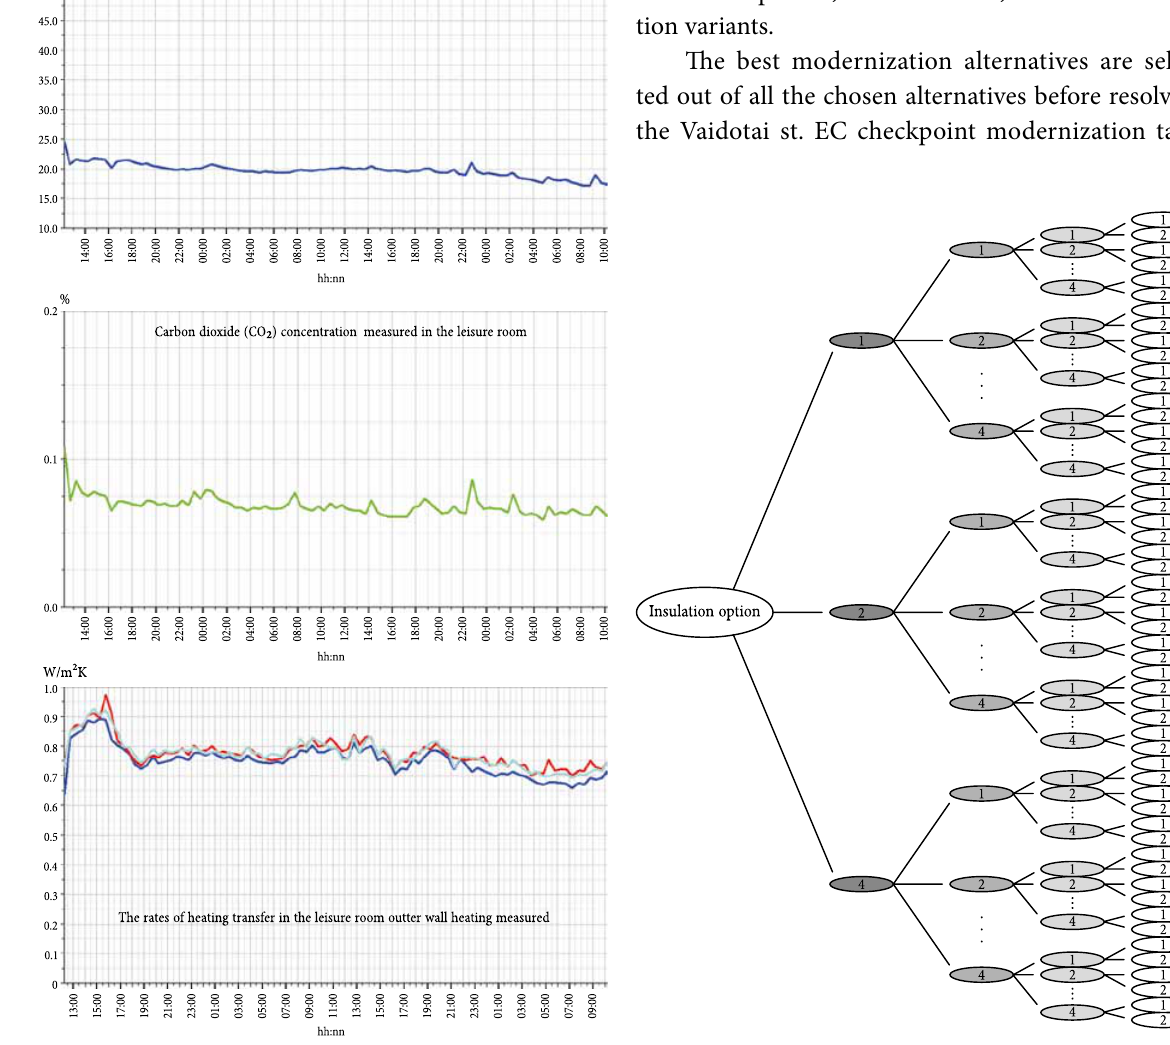
Fig. 3. Relative humidity, CO concentration, external wall 2 surface temperature measurements Fig. 4. Decision